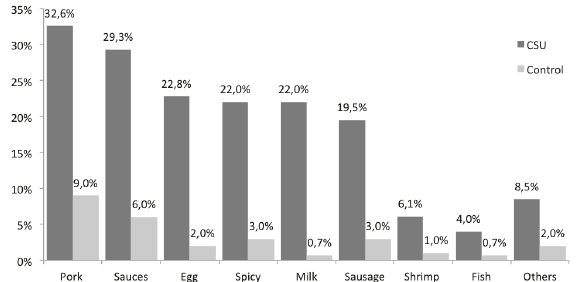
Figure2: Principalfoodssuspectedbyself-report. Principalfoods suspected by patients and control